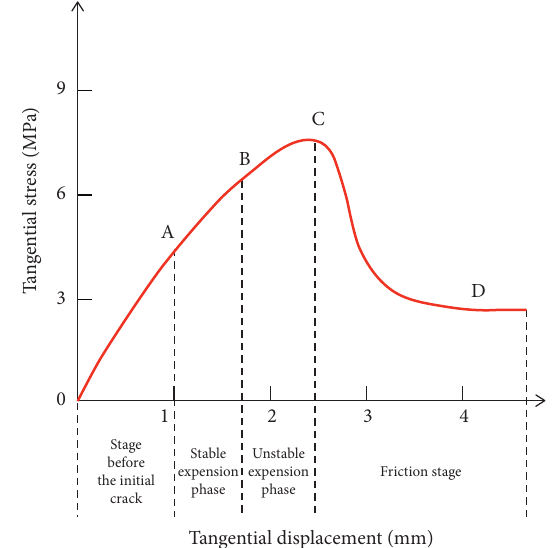
Figure 2: Different stages of shear failure of nonpenetrating jointed rock mass